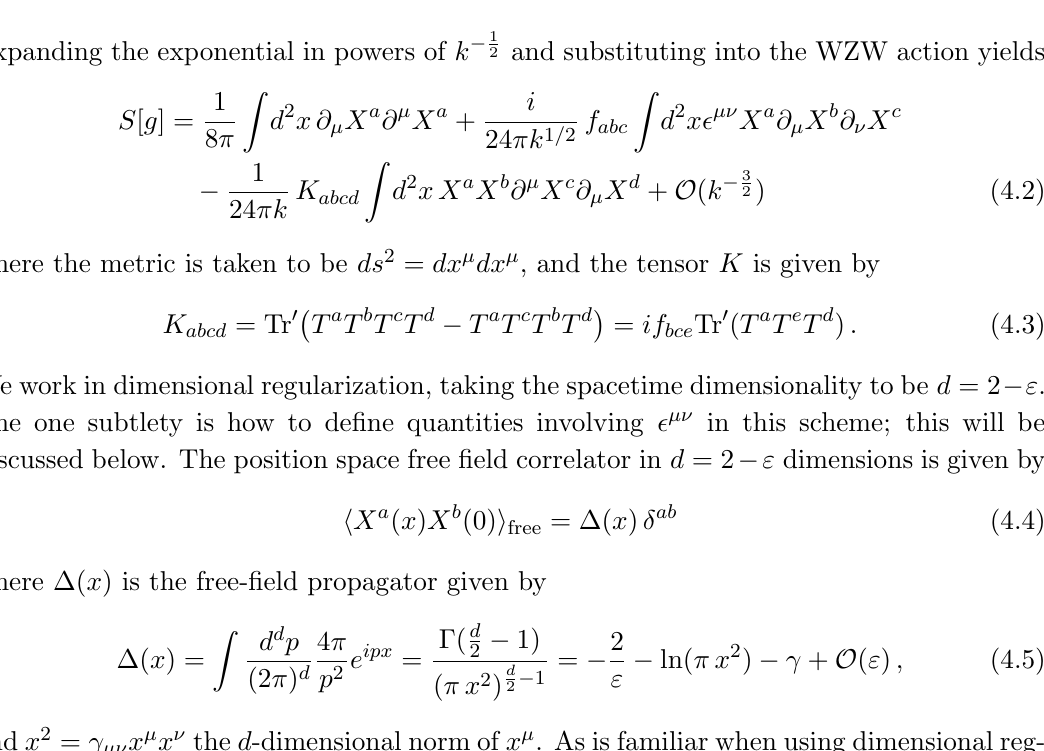
Figure 1 . Feynman diagrams at order 1 =k 2